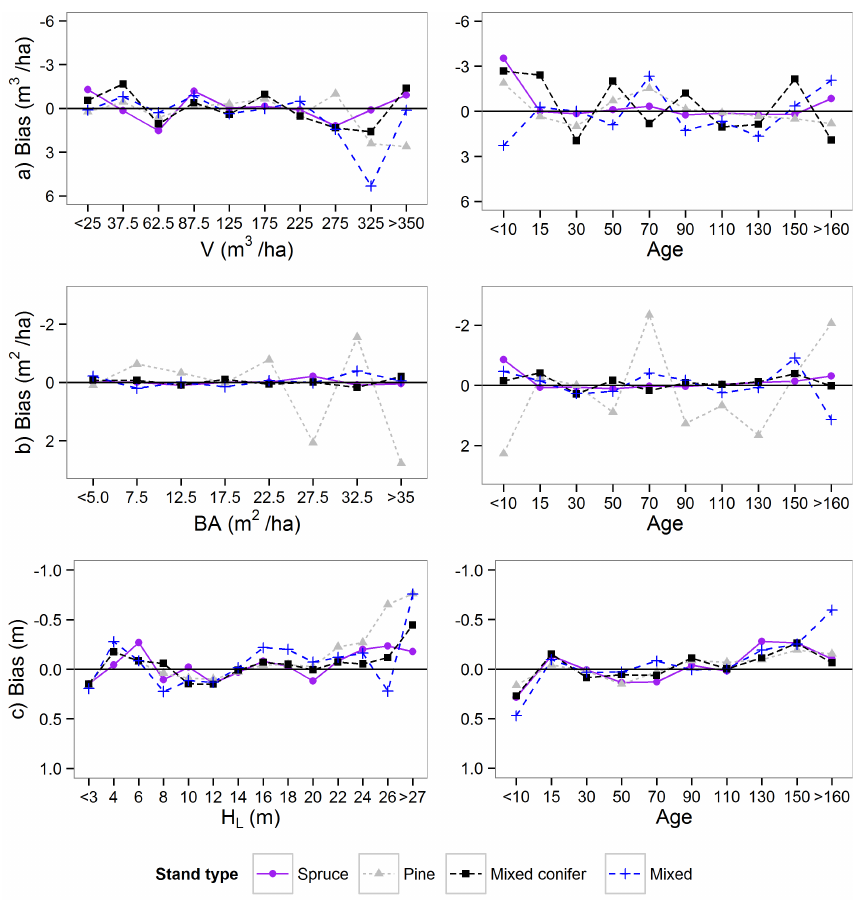
and ( c ) H i (Lorey’s mean height growth), for spruce stands.